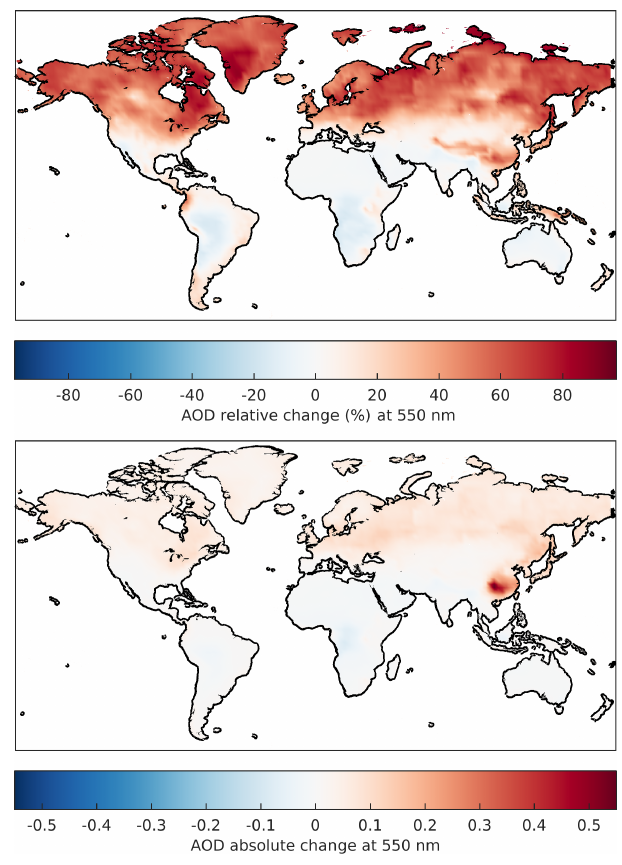
Figure B1. Average relative and absolute change in GEOS-Chem aerosol optical depth at 550nm globally for the year 2006 after im- plementing revised optical tables for SIA and OA.